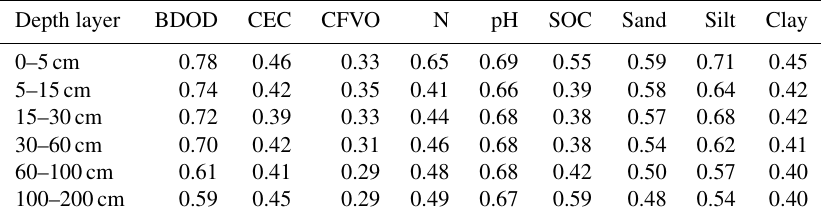
Table 5. MEC per depth layer for mean predictions. See Table 1 for abbreviations and units of the soil properties considered. Depth layer BDOD CEC